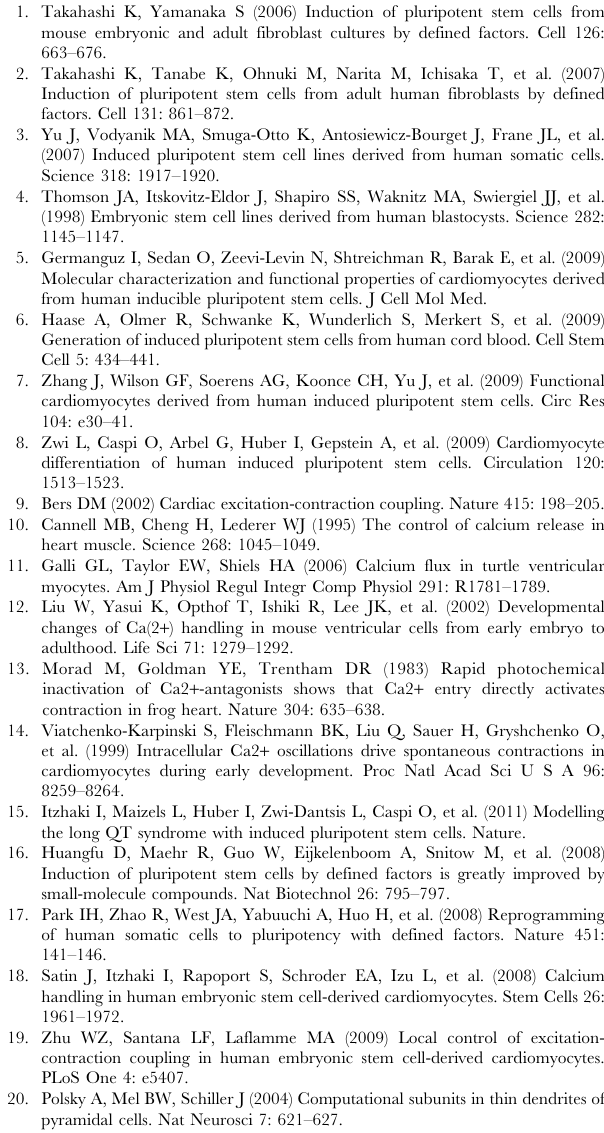
exposure. Abbreviations: F/Fo, fluorescence (F) normalized to baseline fluorescence (Fo); sec, seconds. (PDF) Figure S4 The effect of IP3R inhibition in cardiomyo- cytes derived from the hfib2-5 line. Whole-cell [Ca 2 + ] i transients in representative hfib2-5 hiPSC-CMs before (left) and after (right) 2-APB (2 m M) application (A) and before (left) and after (right) U73122 (2 m M) application (B). Abbreviations: F/Fo, fluorescence (F) normalized to baseline fluorescence (Fo); IP3R, inositol-1,4,5-trisphosphate receptor; sec,